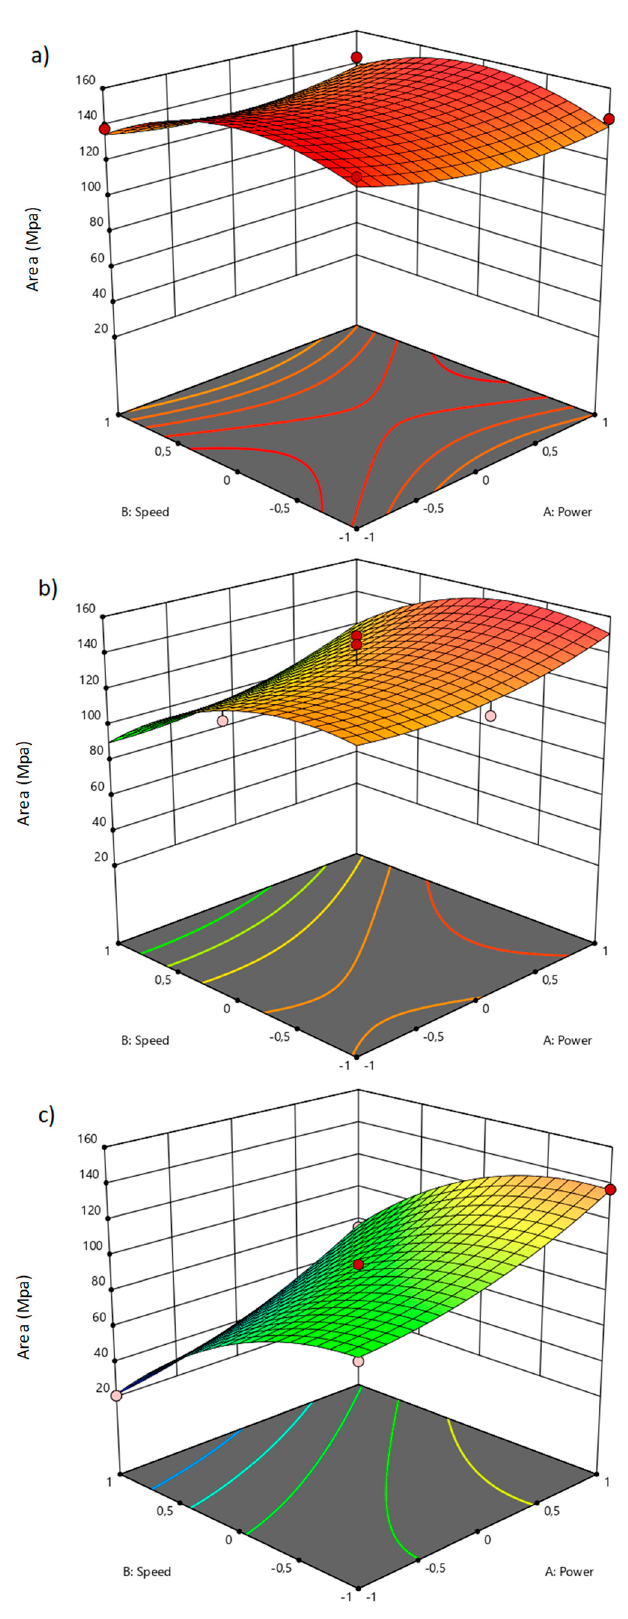
Figure 12. Response surfaces for A , ( a ) H ∗ = − 1 ( b ) H ∗ = 0 ( c ) H ∗ =